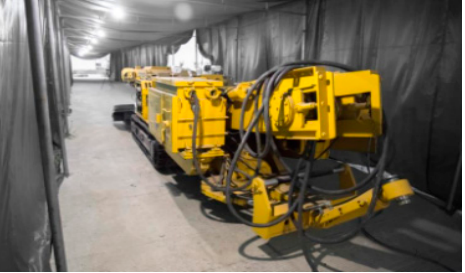
Figure 5. Site of the uniform motion experiment.